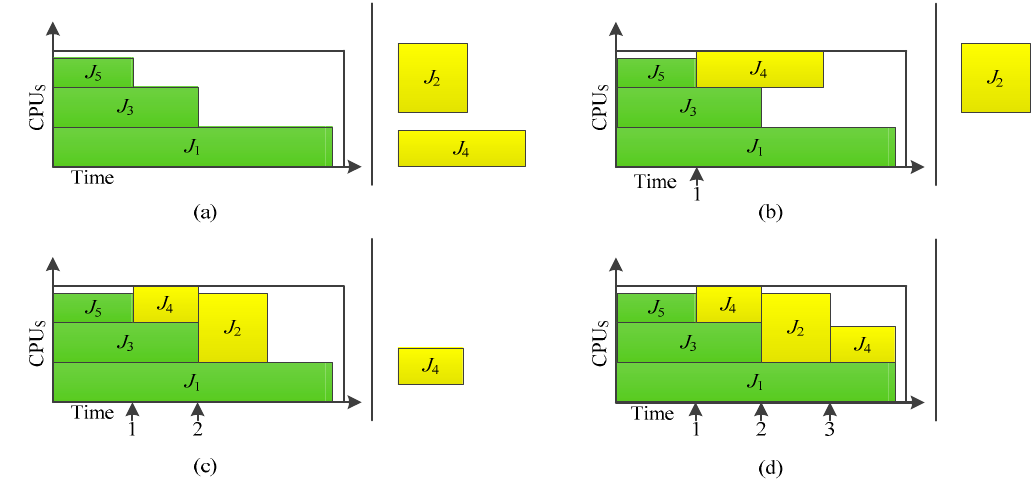
Figure 1. Job scheduling instance based on HDJS; ( a ) t = 10 s; ( b ) t = 20 s; ( c ) t = 30 s; ( d ) t = 40 s.